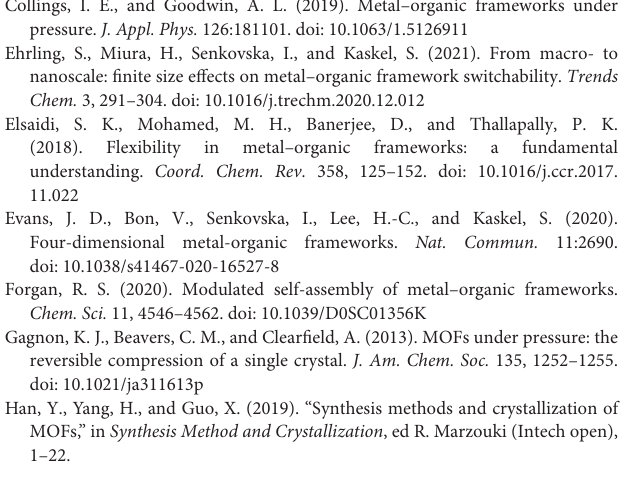
pores in DUT-8(Ni) are preferably accessible from the